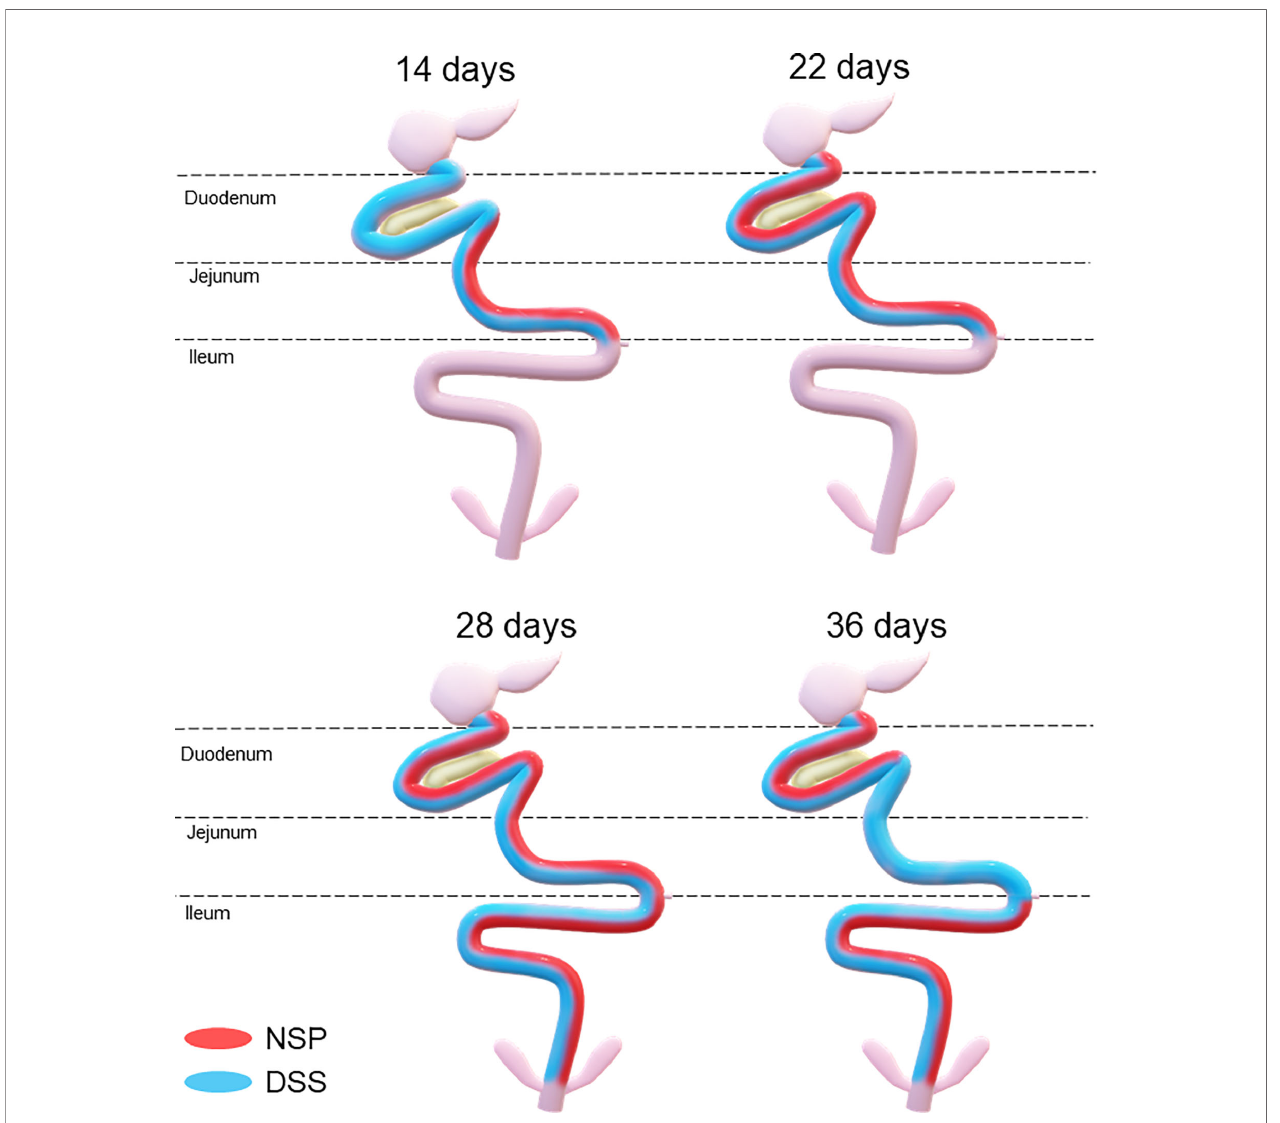
FIGURE 5 | Temporal and spatial evolution of the intestinal in fl ammation response triggered by a high non-starch pollisacharyde diet (NSP) diet or a DSS challenge in broilers. Areas painted with red and/or blue signalizing the affected* areas in birds fed NSP diet (red) or in birds challenged with the DSS protocol (blue). *affected areas: areas with poor intestinal health (higher microscopic ISI